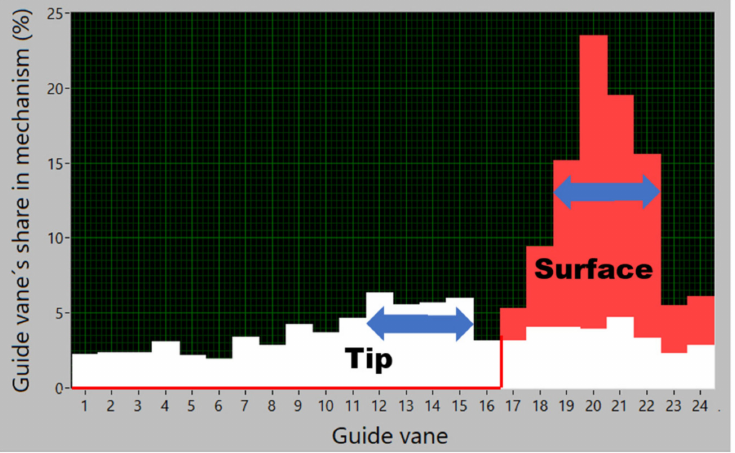
Figure 19. A full quantitative description of the mean role of the guide vanes in each of the two groups of mechanisms. The guide-vane intervals with high cavitation intensity are denoted by the arrows here and by their numbers in Figure